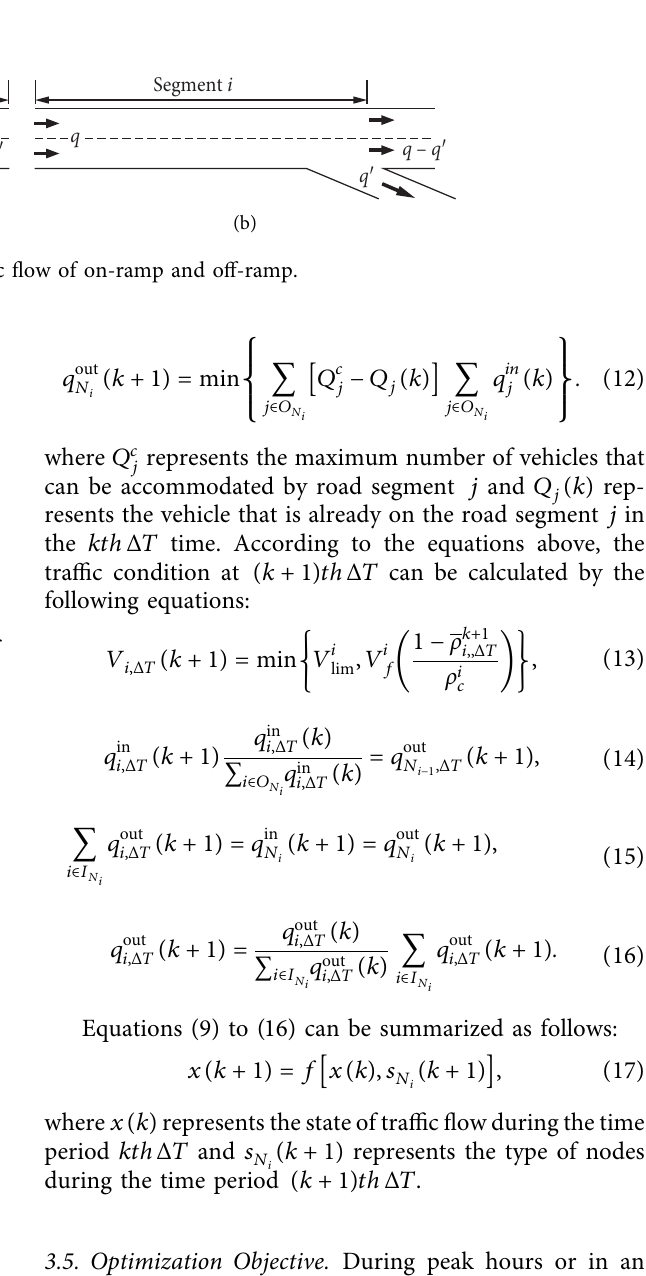
Figure 4: Lane change behavior and its equivalent case.